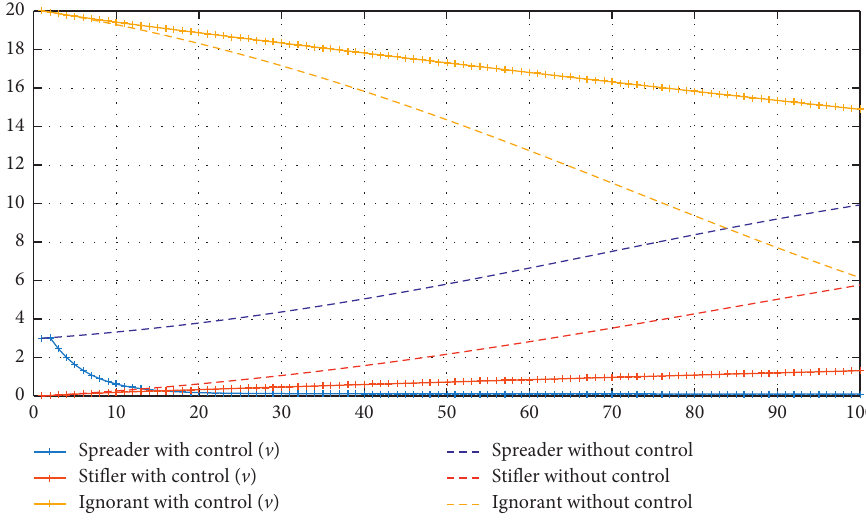
Figure 5: Dynamics with control v .